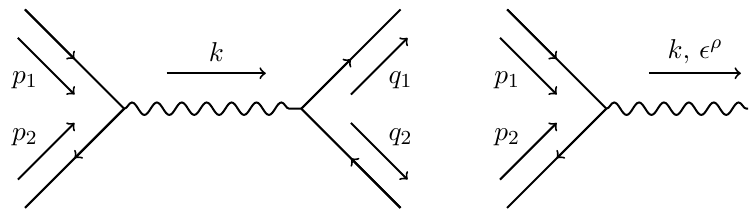
Figure 6 . Feynman diagrams. (Left) Tree level amplitude for t-channel electron positron scattering. (Right) decay of charged fermions into a (bulk) photon with polarization vector (cid:15) (cid:26)